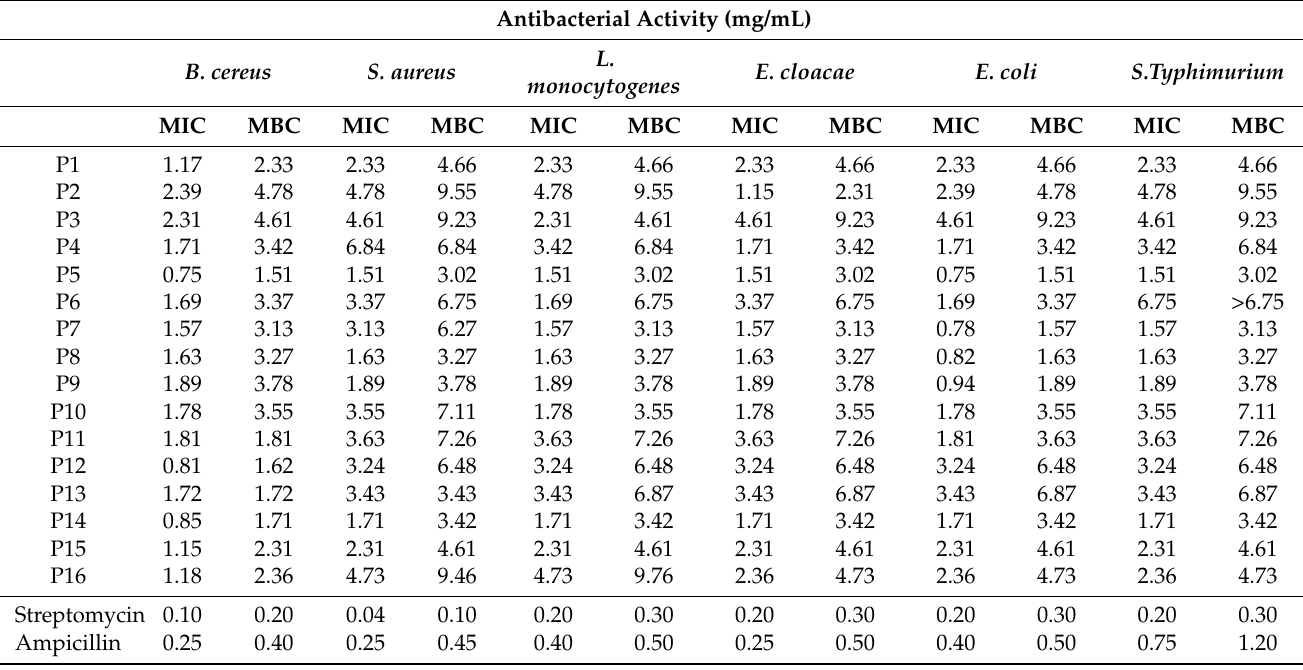
Table 6. Antibacterial activity of the hydroethanolic extracts of the cardoon petioles. Antibacterial Activity